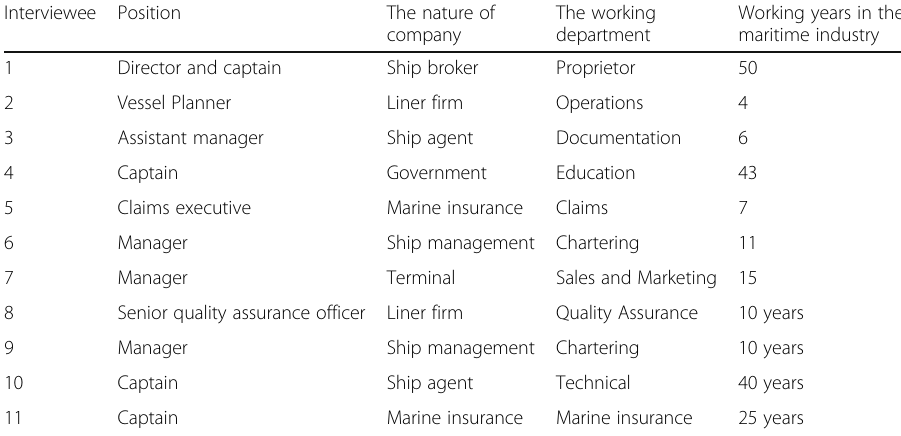
Table 1 Questionnaire survey - list of interviewees Interviewee